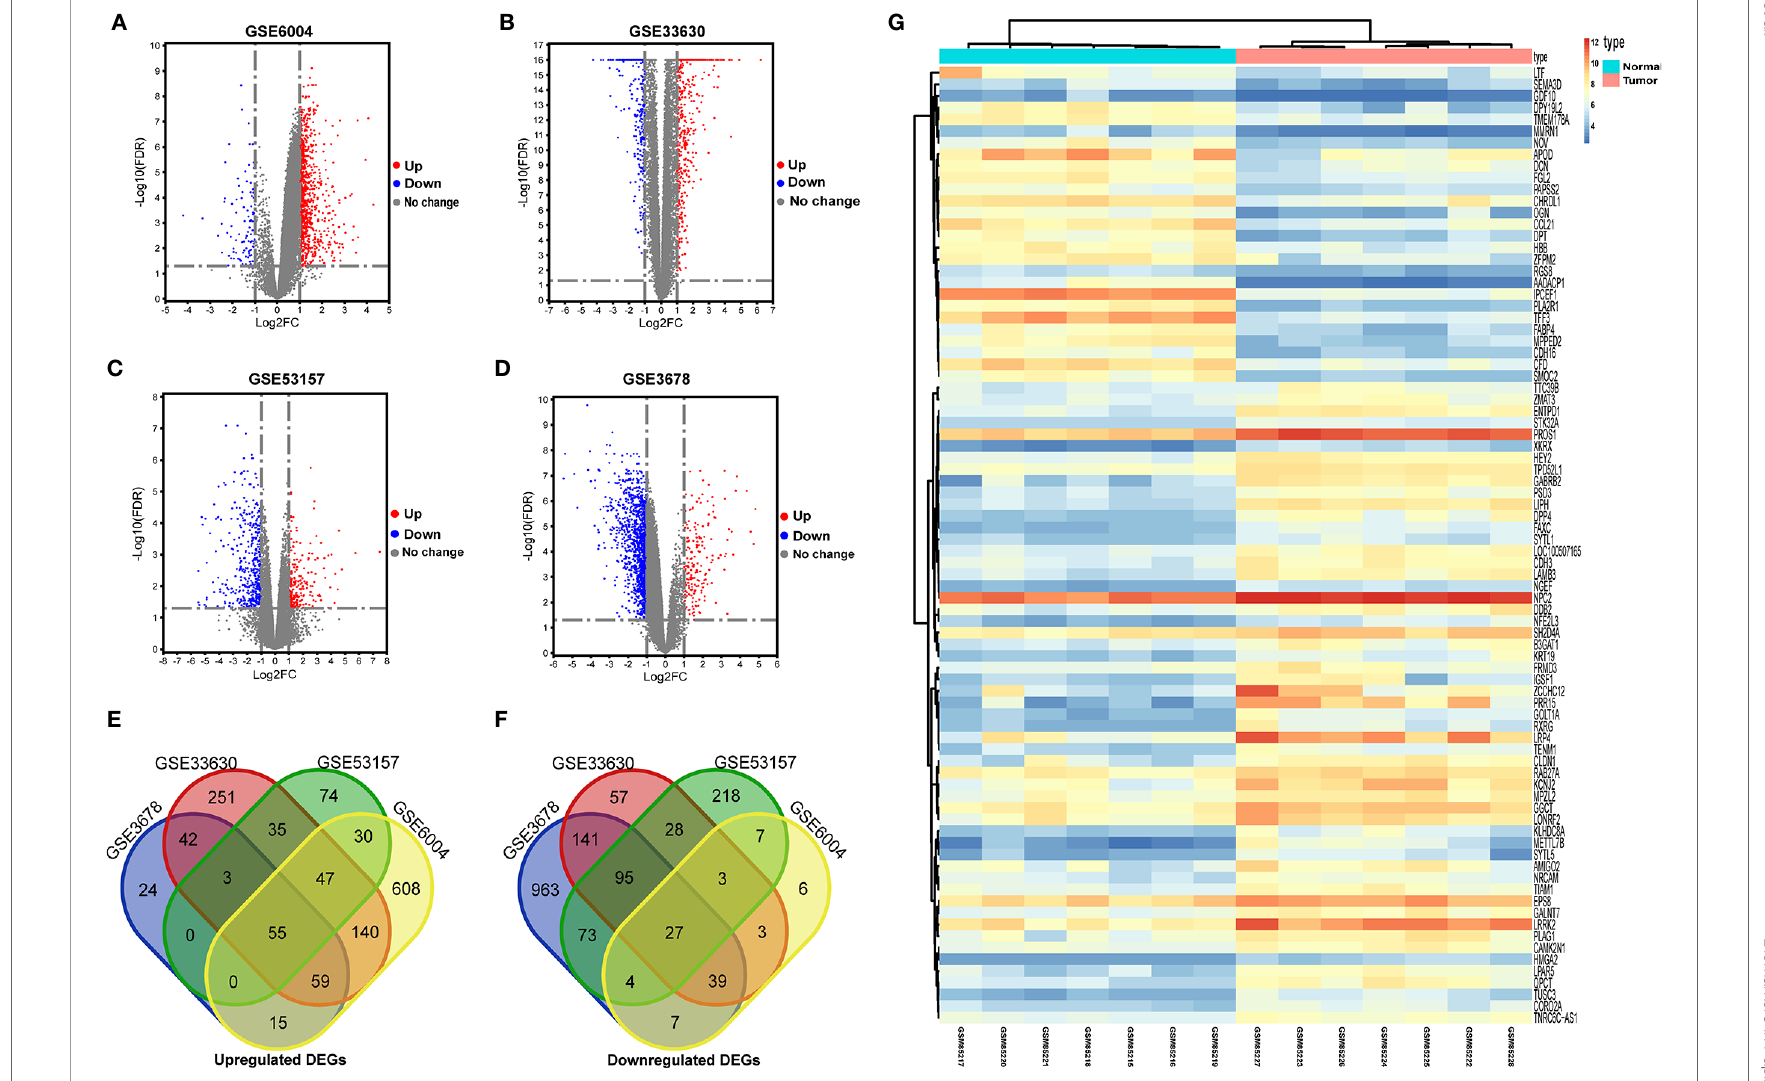
FIGURE 2 | Identi fi cation of differentially expressed genes in PTC from public GEO datasets. (A – D) Volcano plots of DEGs in the four indicated datasets. DEGs, differentially expressed genes. X-axis: log 2 (FC); Y- axis: -log 10 (FDR) for each gene. Genes with FDR < 0.05 and FC > 1.0 or < -1.0 are considered DEGs for each dataset. Blue: downregulated genes; Grey: no differentially expressed genes; Red: upregulated genes. (E, F) Screening of DEGs in mRNA expression pro fi ling datasets GSE3678, GSE6004, GSE33630, and GSE53157. (E) The overlapping regions indicate the commonly upregulated DEGs. (F) The overlapping regions indicate the commonly downregulated DEGs. (G) Representative heat map of the 82 overlapping genes between PTC and normal samples in the GSE3678 dataset. Orange represents higher expression and blue represents lower